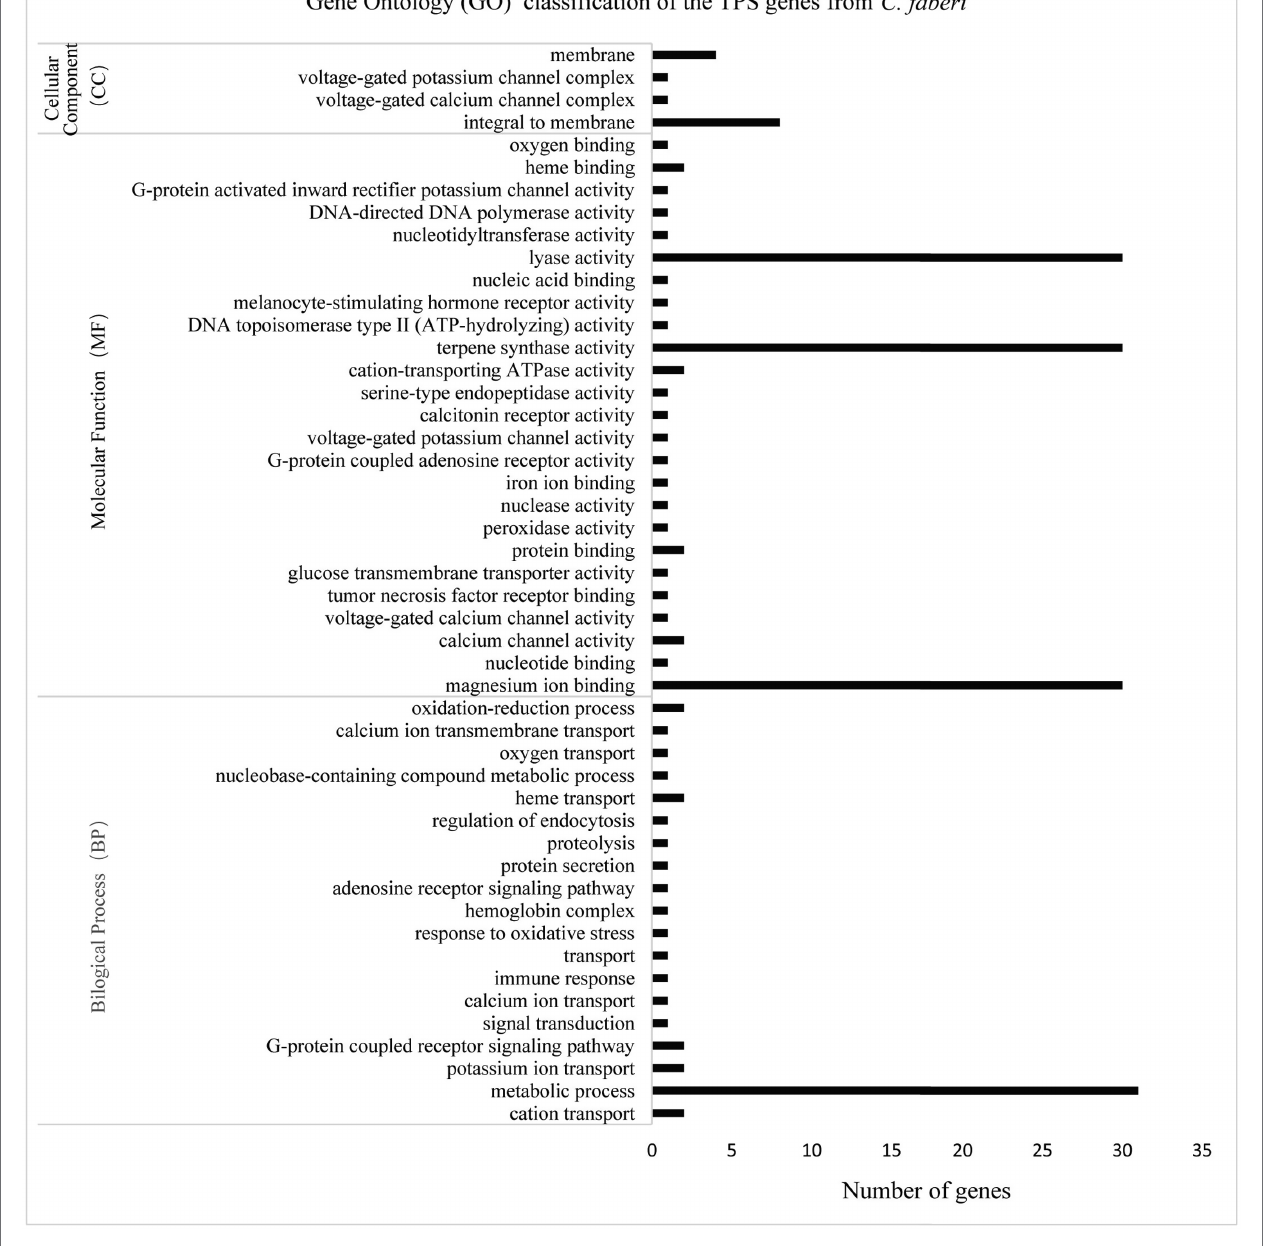
FIGURE 7 | Gene ontology (GO) classification of CfTPS genes. GO annotation details are listed in Supplementary Table S10